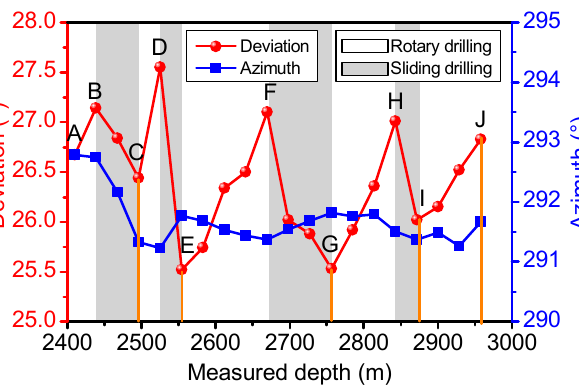
Figure 13. Deviation and azimuth versus measured depth for the well interval of 2400–3000 m in well B. Figure 12. The trajectory of well B, where the blue points represent the survey data, the red points Table 3. The trajectory of test interval in well B. represent the subpoint of the survey data in three coordinate planes, the red full line represents the real drilling trajectory, and the blue dotted lines represent the subline of the real drilling trajectory in three coordinate planes.